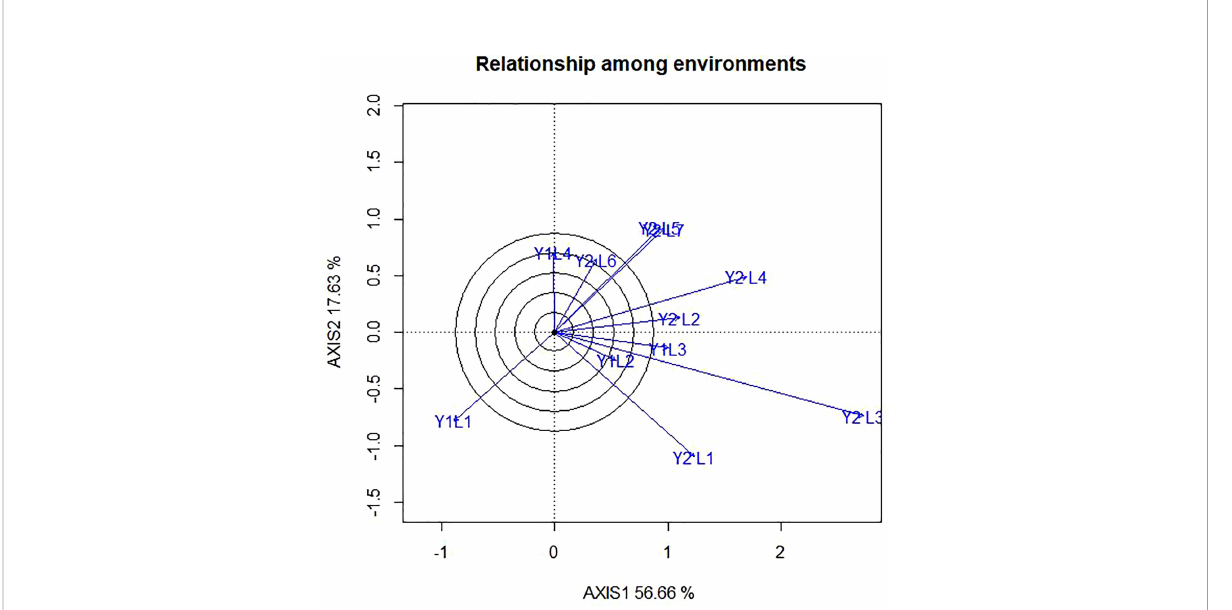
FIGURE 5 The vector view of GGE biplot showing the relationship among environment (tested environment with the ideal environment) of 11 soybean genotypes two years (11 environments) for grain yield per hectare. The biplots were created based on Centering = 0, SVP = 2, Scaling =